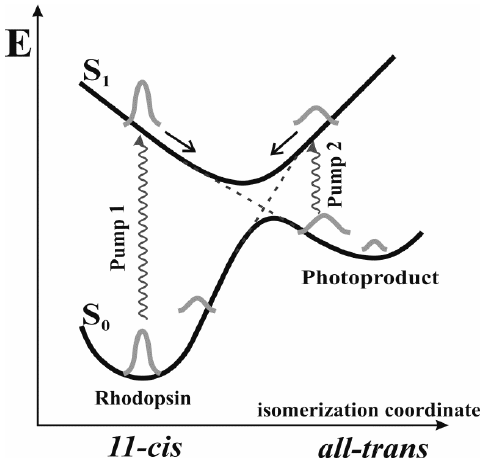
Figure 4. The scheme of the potential energy surfaces of the visual pigment rhodopsin explaining the principle of its